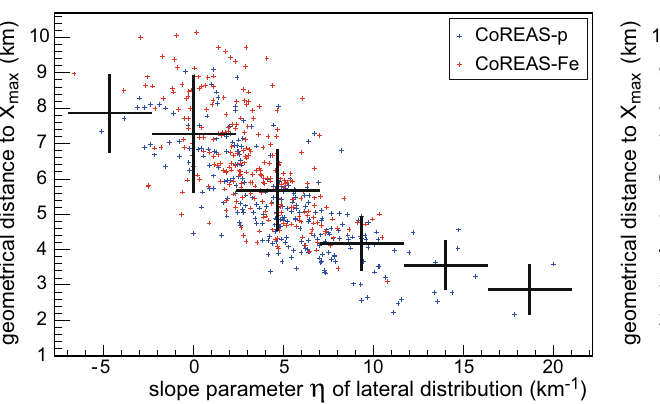
the contained KASCADE events. The profile in black denotes the mean and standard deviation in each